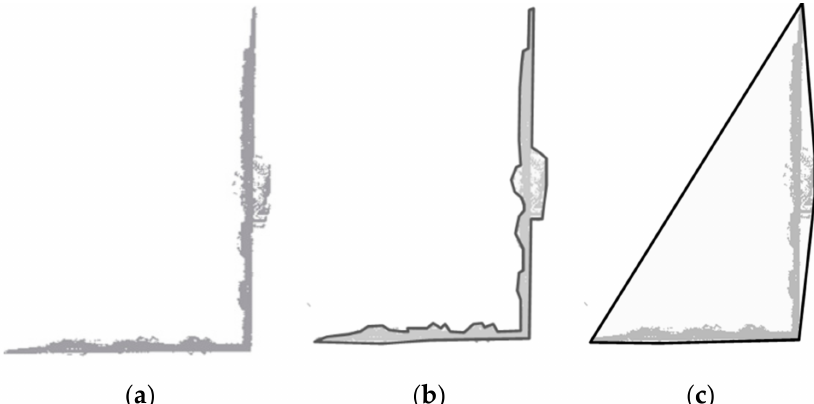
Figure 6. Horizontal hollow ratio of multi-wall building. ( a – c ) show the projected points, projection area and convex hull, respectively. The empty area after the facade forms a smaller horizontal hollow ratio than other